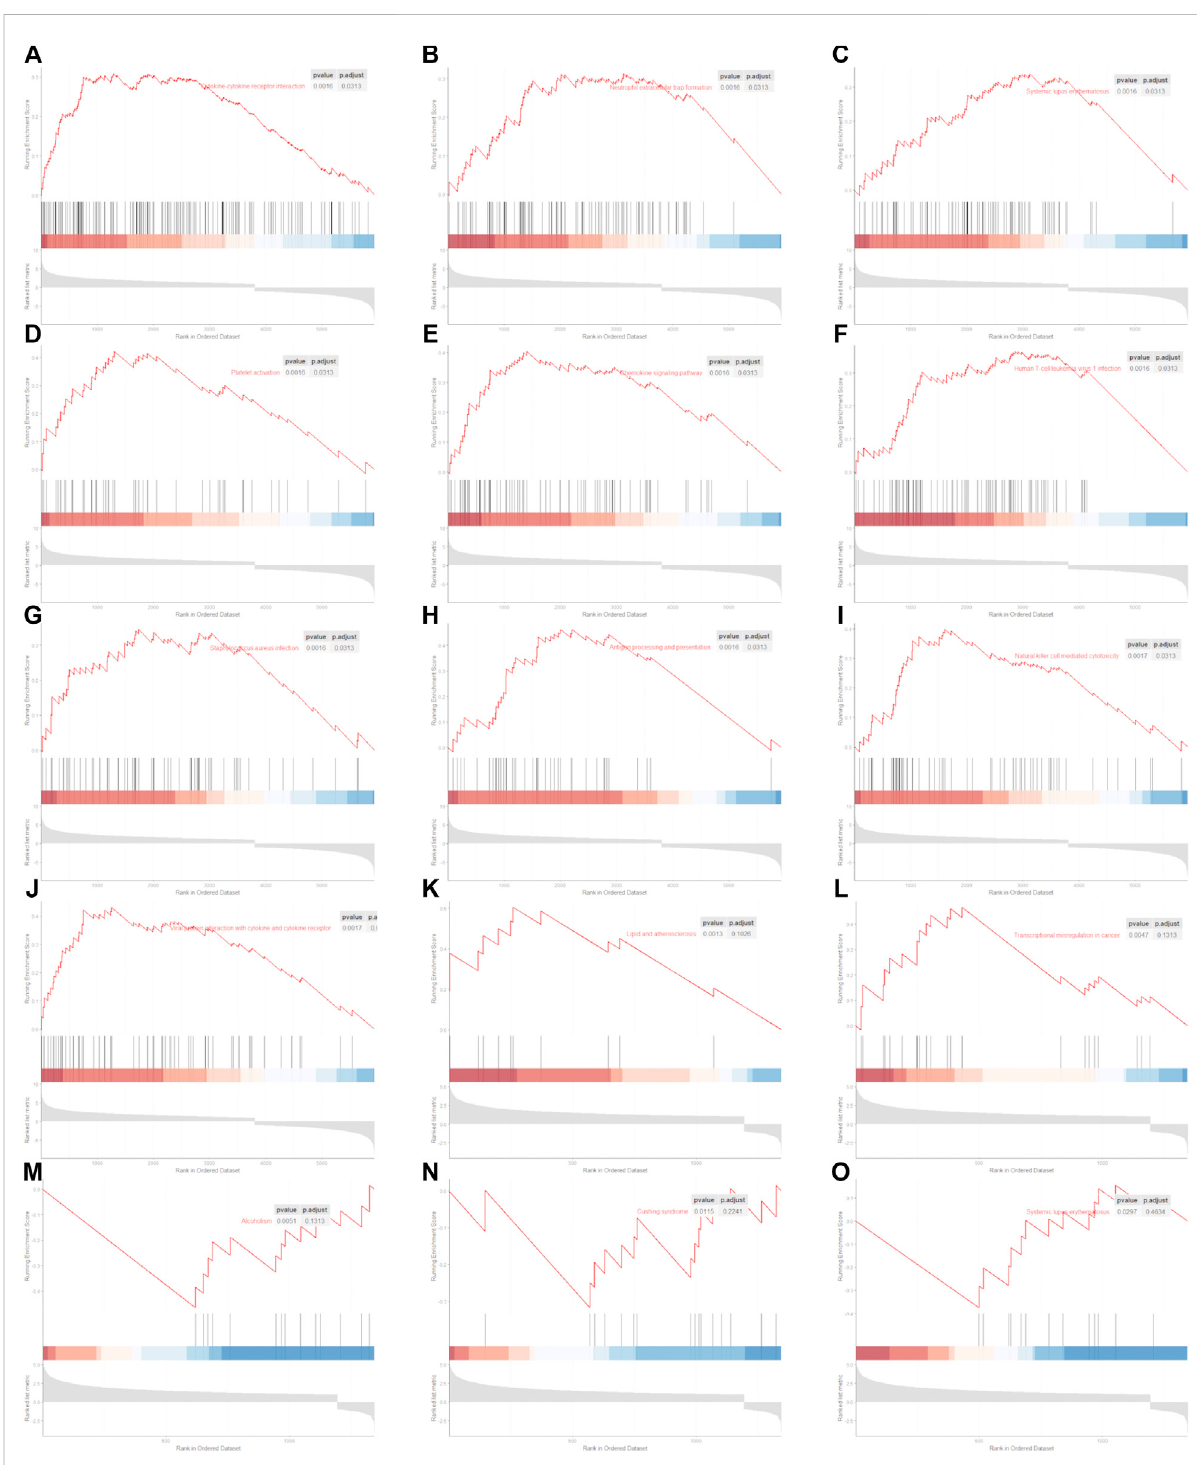
FIGURE 6 Signi fi cantly enriched KEGGpathway. (A – J) Top10signi fi cantly enriched signaling pathways between normal andKIRC. (A) Cytokine – cytokine receptor interaction. (B) Neutrophil extracellular trap formation. (C) Systemic lupus erythematosus. (D) Platelet activation. (E) Chemokine signaling pathway. (F) Human T-cell leukemia virus 1 infection. (G) Staphylococcus aureus infection. (H) Antigen processing and presentation. (I) Natural killer cell-mediated cytotoxicity. (J) Viral protein interaction with cytokine and cytokine receptor. (K – O) Five signi fi cantly enriched signaling pathwaysbetweenpatientswithKIRCwithlowCIFIvalueandpatientswithKIRCwithhighCIFIvalue. (K) Lipidandatherosclerosis. (L) Transcriptional misregulation in cancer. (M) Alcoholism. (N) Cushing syndrome. (O) Systemic lupus